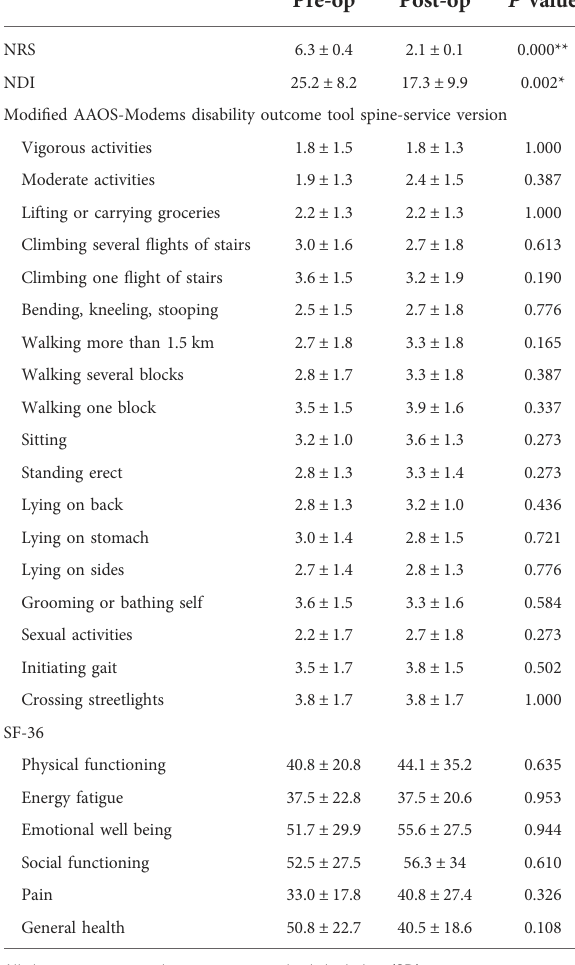
TABLE 2 Clinical outcomes of patients preoperatively and at last postoperative follow-up.